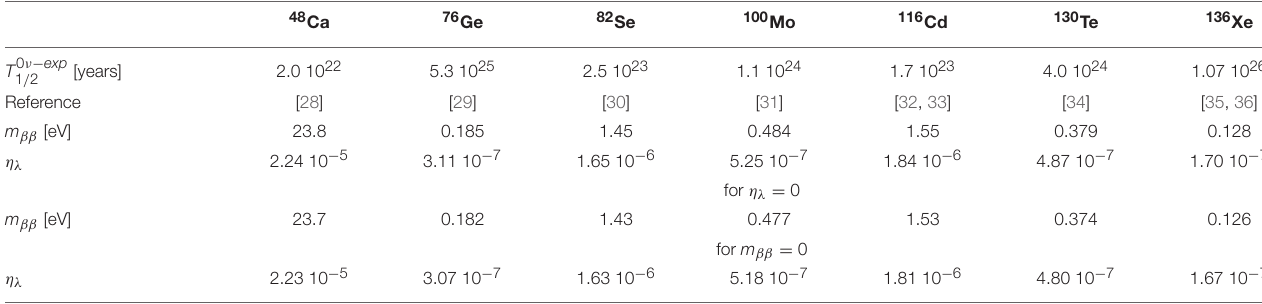
TABLE 2 | Upper bounds on the effective Majorana neutrino mass m ββ and parameter η λ associated with right-handed currents mechanism imposed by current constraints on the 0 νββ -decay half-life for nuclei of experimental interest.